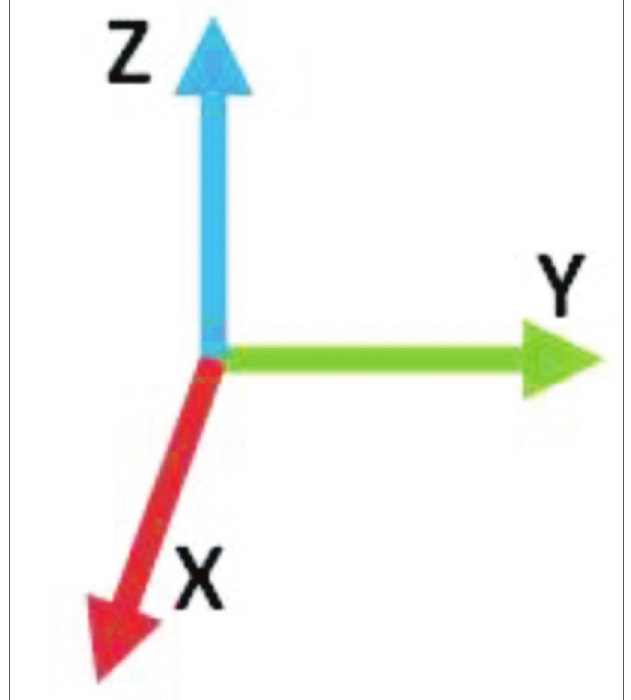
Figura 6 . Eixos X, Y e Z.